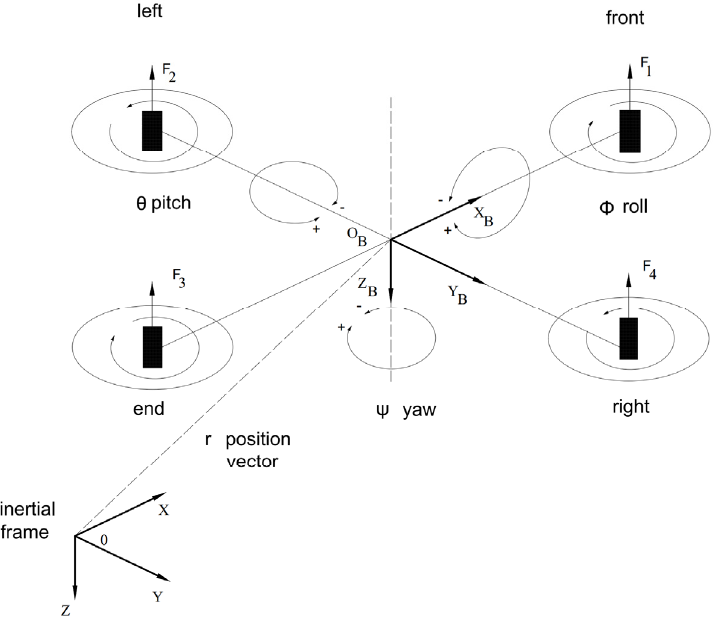
Figure 2. Configuration and coordinate systems of Quadcopter.